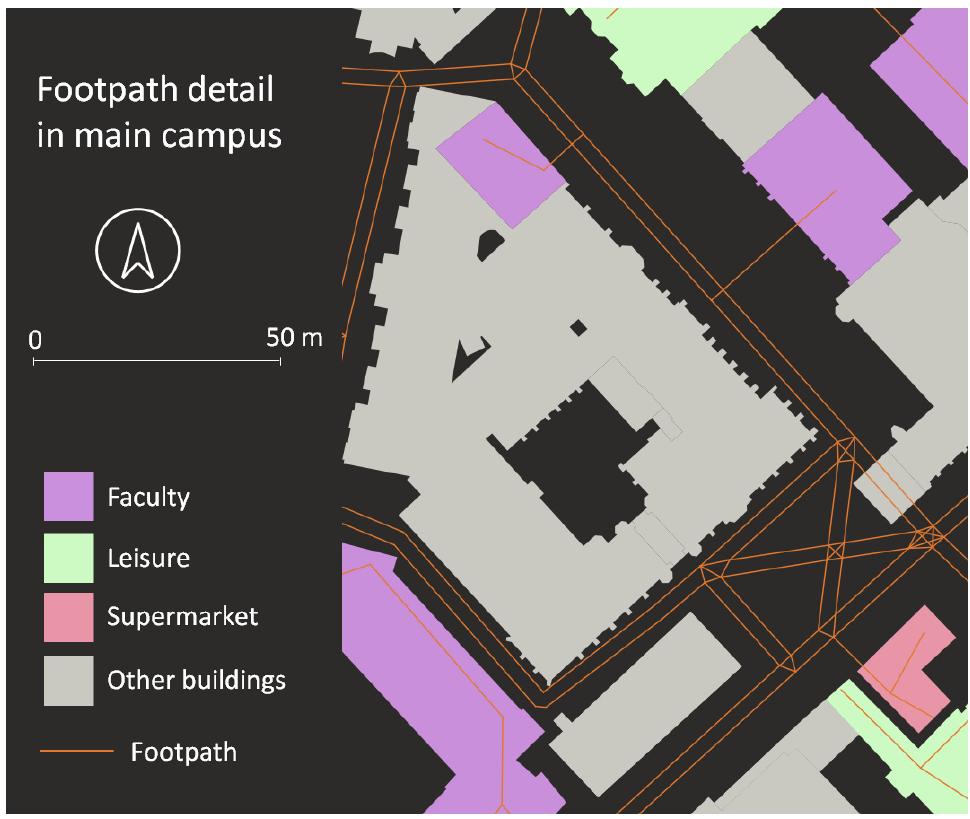
Figure 2. Detail of the footpath network in the main university campus. Contains Ordnance Survey data © Crown copyright and database right 2020.